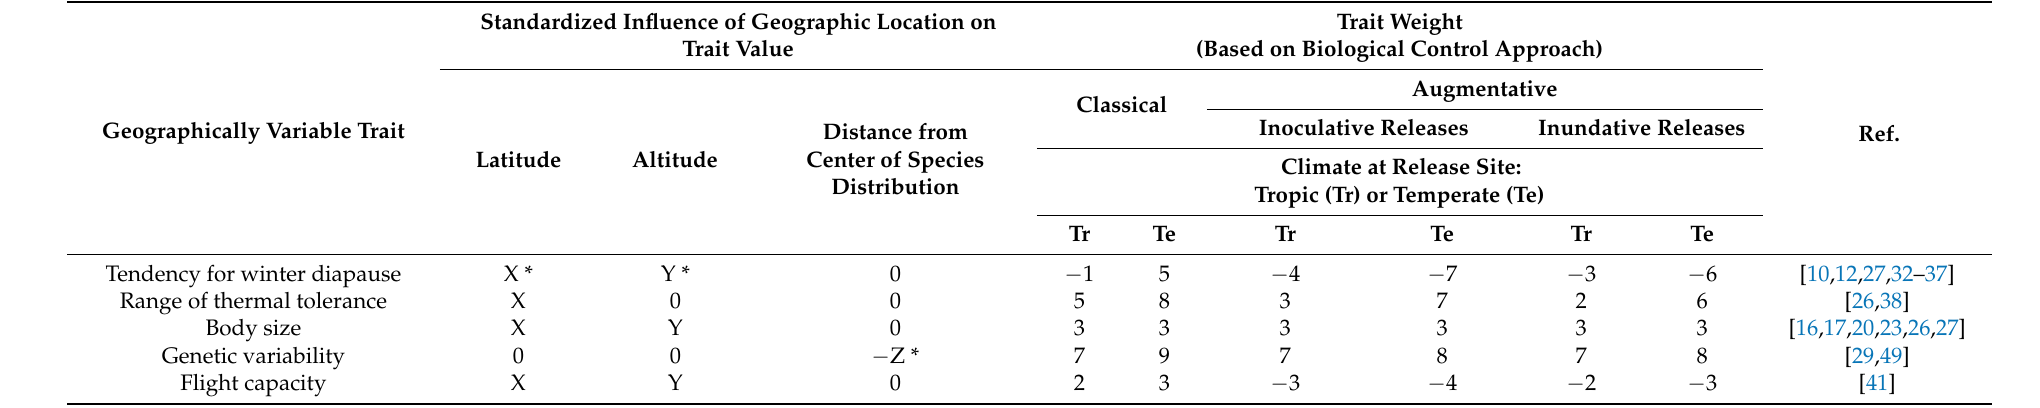
Table 1. Quantitative heuristic framework for evaluating the suitability of natural enemy collection sites. See text and Appendix A for